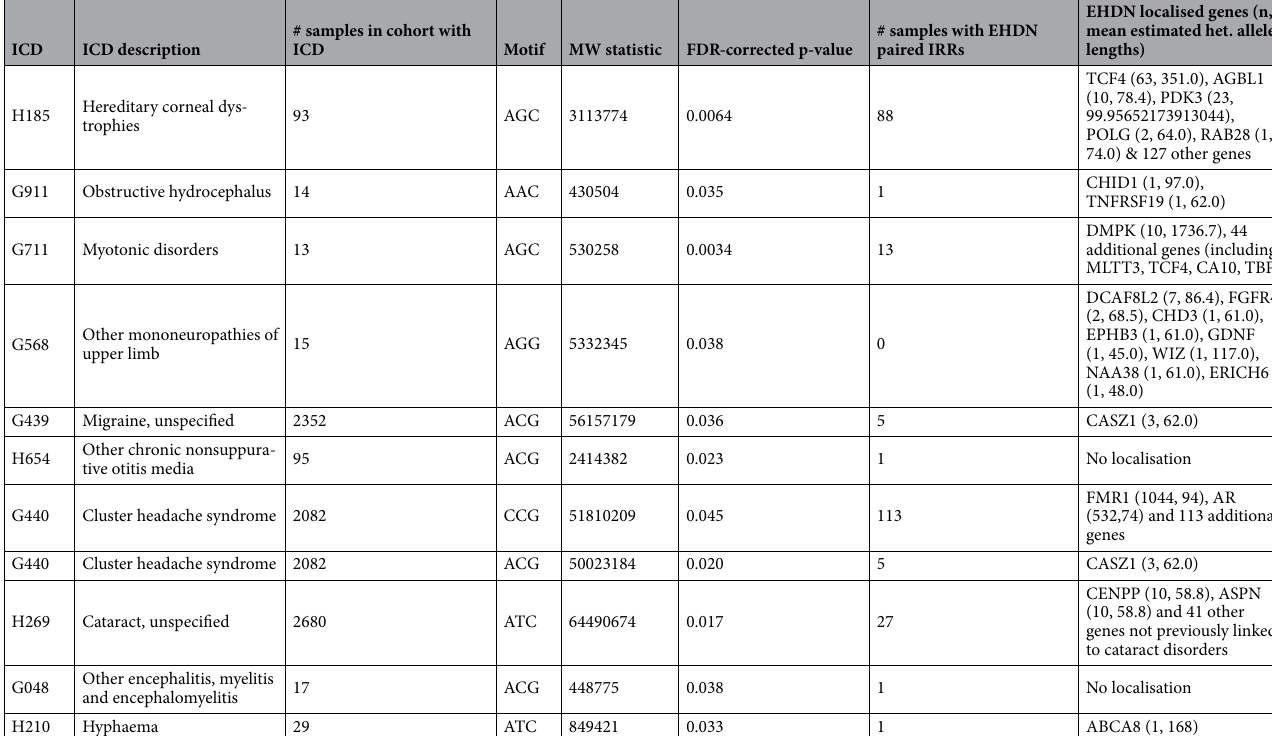
Table 1. superSTR analysis of UK Biobank data—significant trimers in motif screening of ICD10 codes and post-screening localization of reads in samples and codes identified by superSTR by EHDN. Repeat sizes are as reported by EHDN, and are listed for qualitative purposes only due to high uncertainty resulting from low coverage and numbers of supporting reads in some areas of the WES data. A single individual may have expansions of the same motif at multiple loci. IRRs refer to paired reads detected by EHDN where both reads are repetitive, with the same motif, and > 90% of the reads is the specified motif. Highlighted genes have associations with related disorders. An extended version of the above table with complete gene lists incorporating data from tetramers and pentamers is included in Supplementary Data